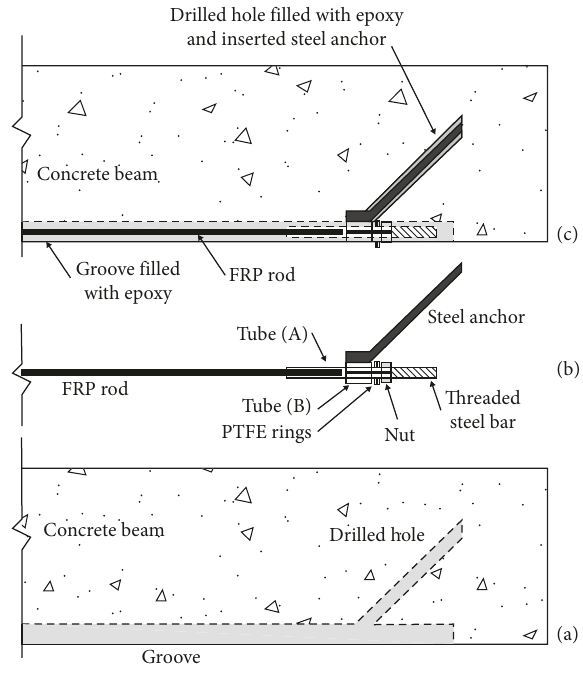
Figure 7: Installation and setup of anchor proposed by Lecce University [7].